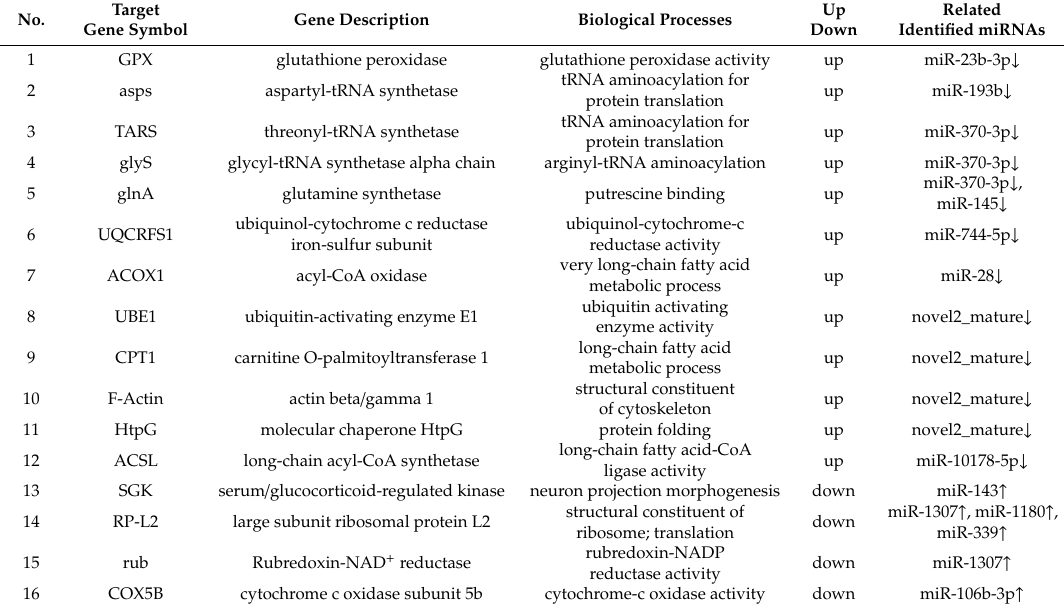
Table 4. Potential role of miRNAs and selected target genes in the encystment of P. cristata . Target No. Gene